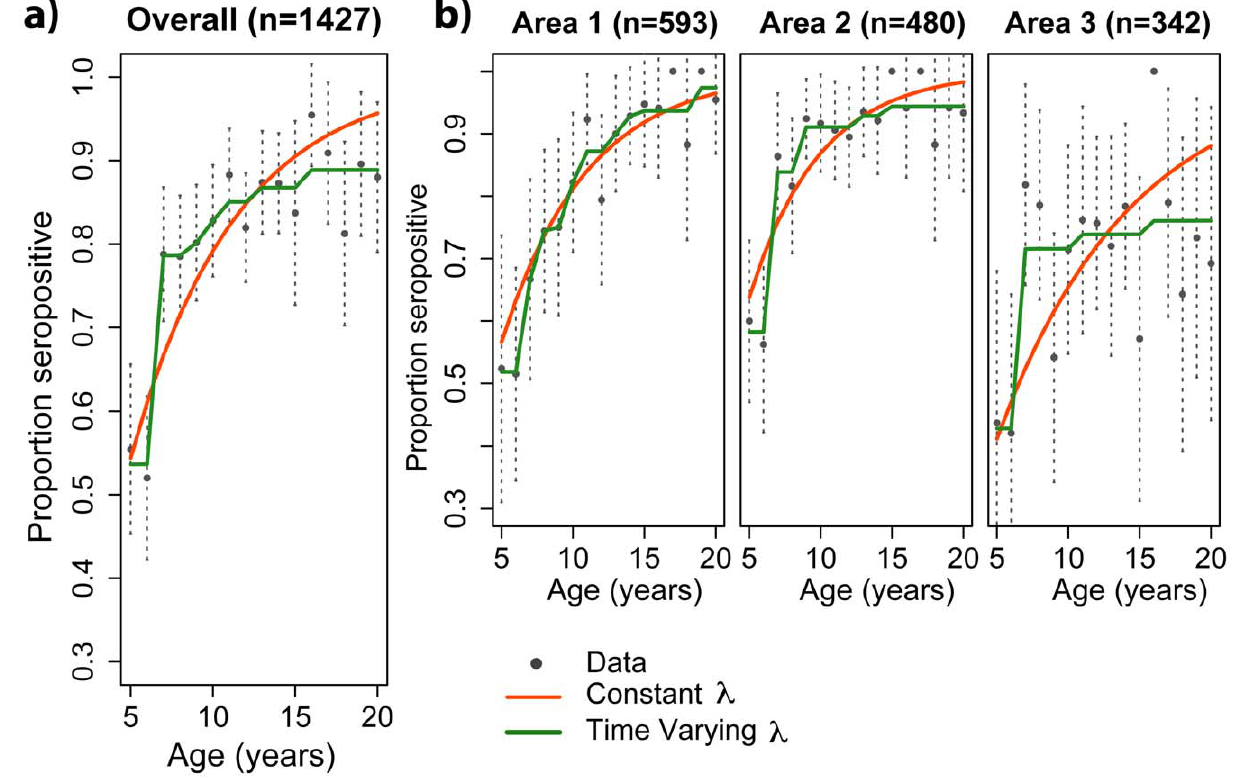
Figure 1. Age specific seroprevalence of dengue in Recife, 2006. Age-specific seroprevalence data a) for the whole sample and b) for each specific area. The lines show the fit of 1) constant (red lines) and 2) time-varying models (green lines) to the age-specific seroprevalence data (black dots). 95% confidence intervals of seroprevalence data are shown by the dotted vertical lines.